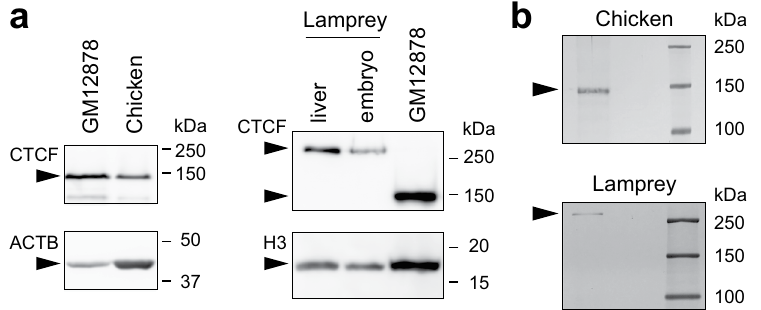
Figure 2. Identification of CTCF proteins. ( a ) Western blotting of CTCF proteins, using an anti-CTCF antibody. Protein extracts from human GM12878 cells, stage 32 chicken embryo, adult lamprey liver, and stage 27 lamprey embryos were used for the analysis. β -actin (ACTB) or histone H3 was used as a loading control protein. ( b ) Immunoprecipitation. Silver-stained SDS PAGE gel of IP proteins showing chicken CTCF protein of approximately 140 kDa, and lamprey CTCF protein of > 250 kDa. Detailed procedures of western blotting and immunoprecipitation are described in Supplementary Materials and Methods. Note that the band positions may not be accurate possibly because of posttranslational